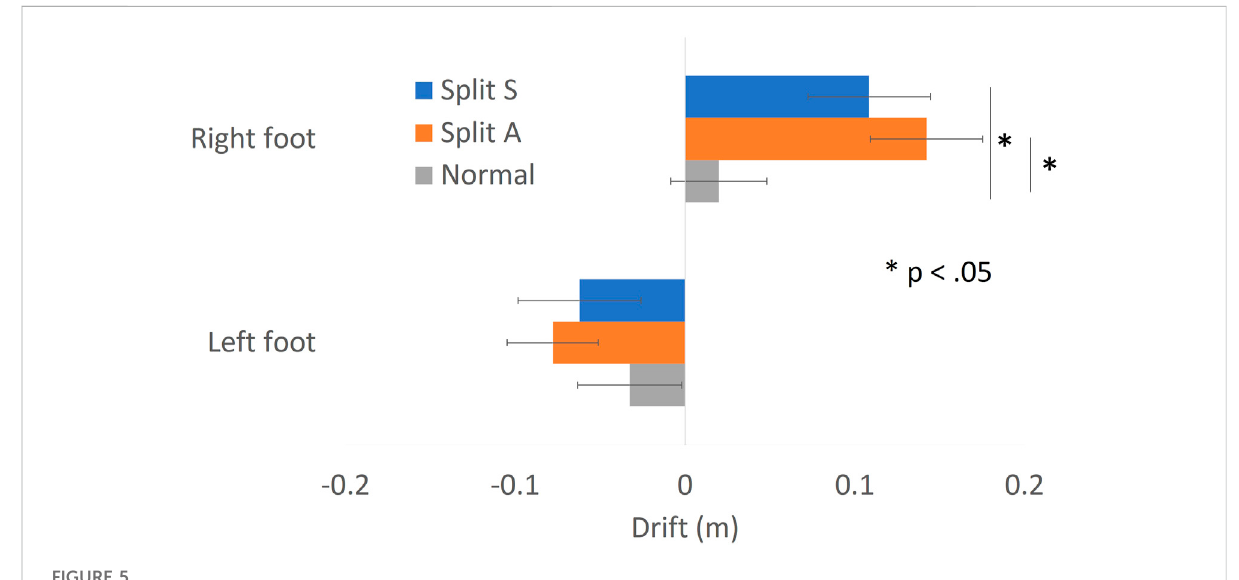
FIGURE 5 MIT results; the error bars indicate